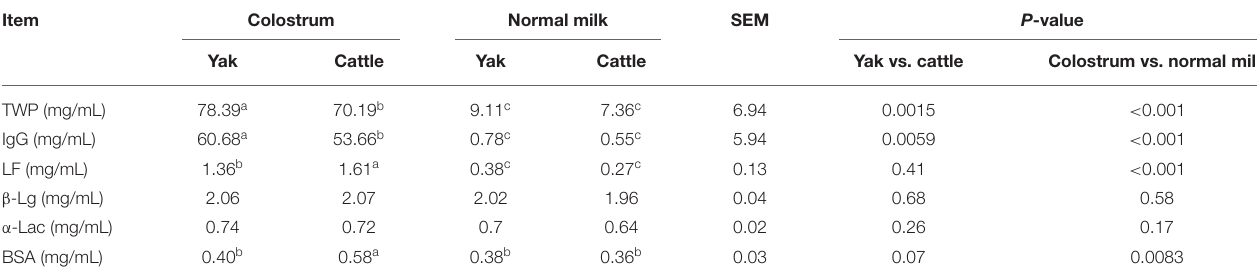
TABLE 1 | Analysis on the concentration difference of major and minor proteins in colostrum and normal milk between yak and cattle. Item Colostrum Normal milk SEM P -value Yak Cattle Yak Cattle Yak vs. cattle Colostrum vs. normal milk TWP (mg/mL) <